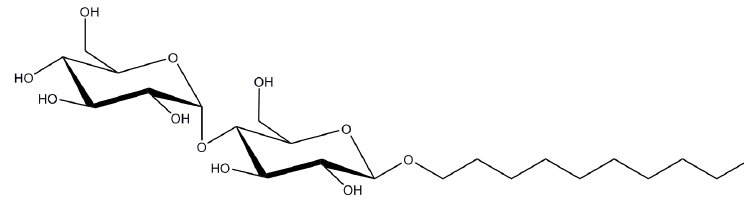
Figure 4. Structure of Decyl maltoside (DM) (chemical formula is C 22 H 44 O 11 ).